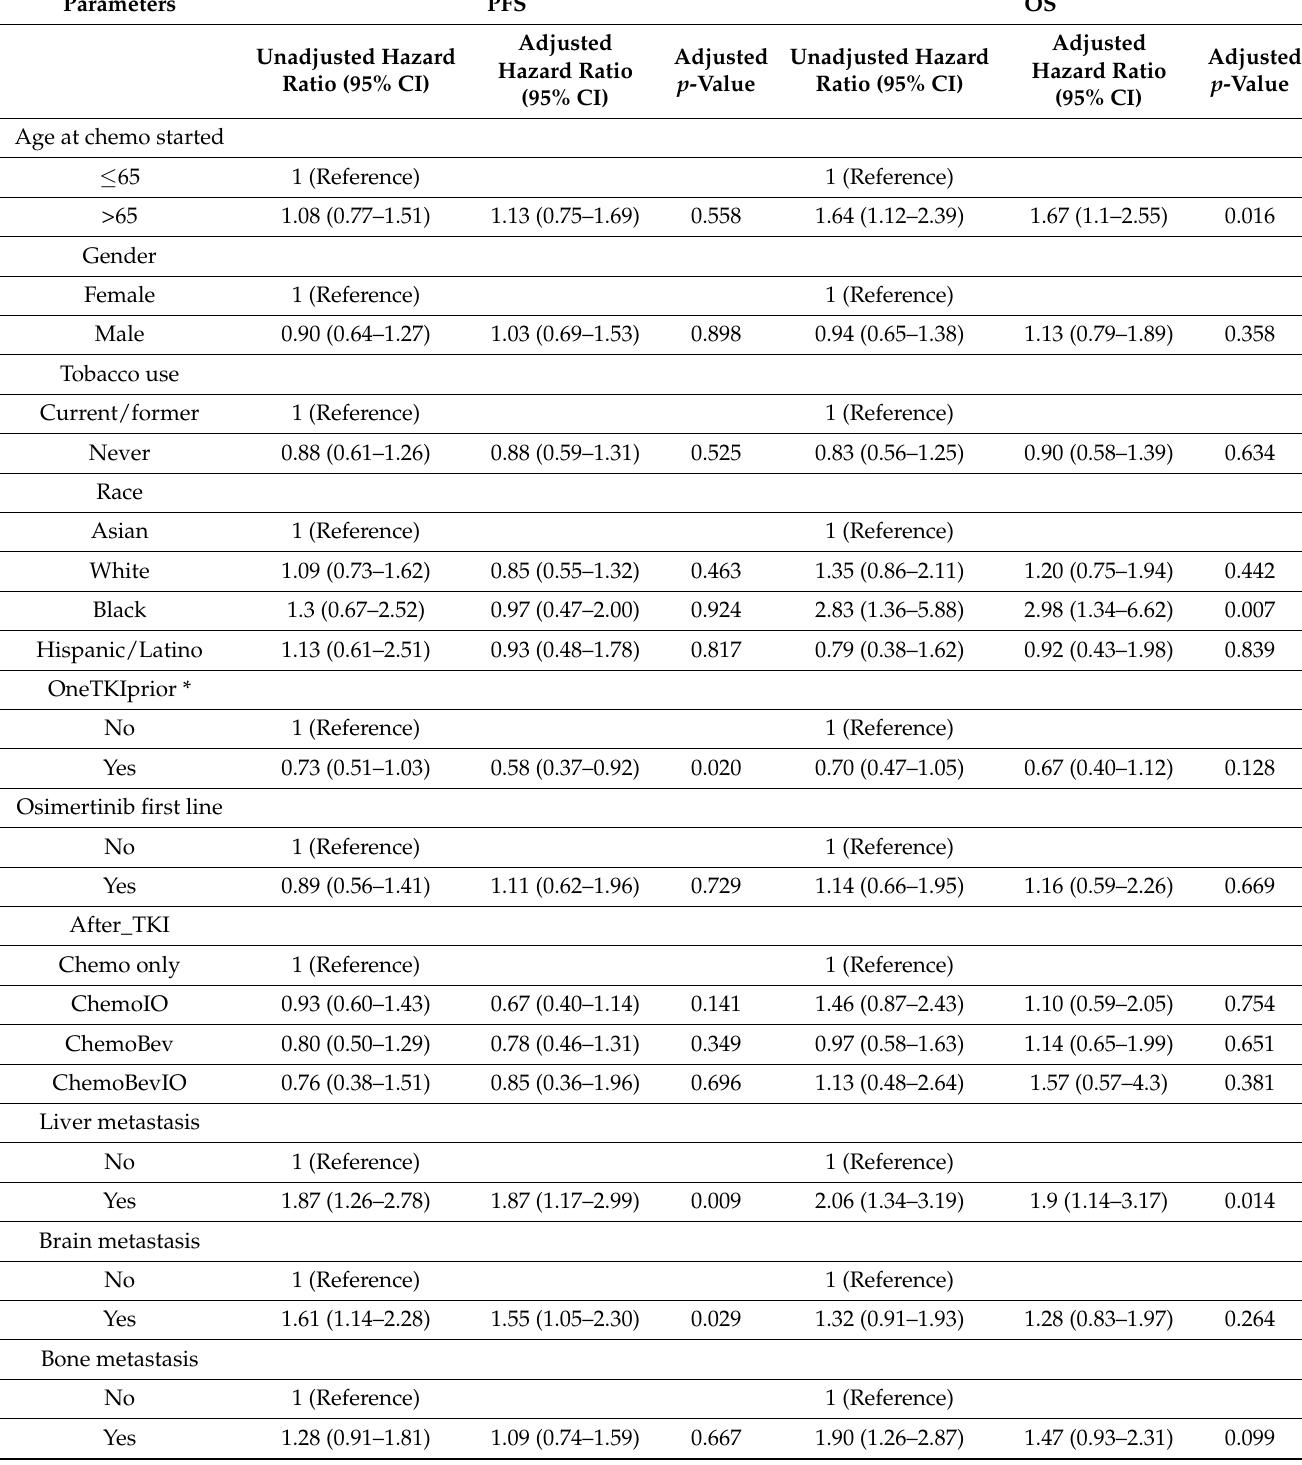
Table 2. Univariate and multicovariate Cox regression for progression-free survival (PFS) and overall survival (OS) among the chemotherapy-based treatment cohort ( n =